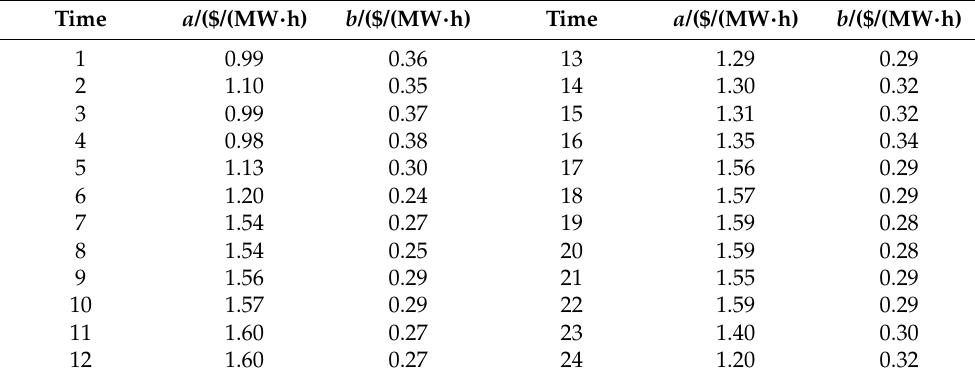
Table A2. Quotation factor for wind producer 2.